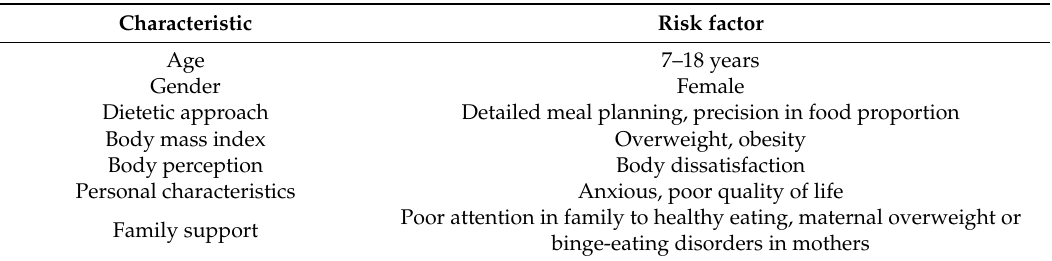
Table 1. Characteristics of eating disorders (EDs) and disordered eating symptoms (DES) among adolescents with type 1